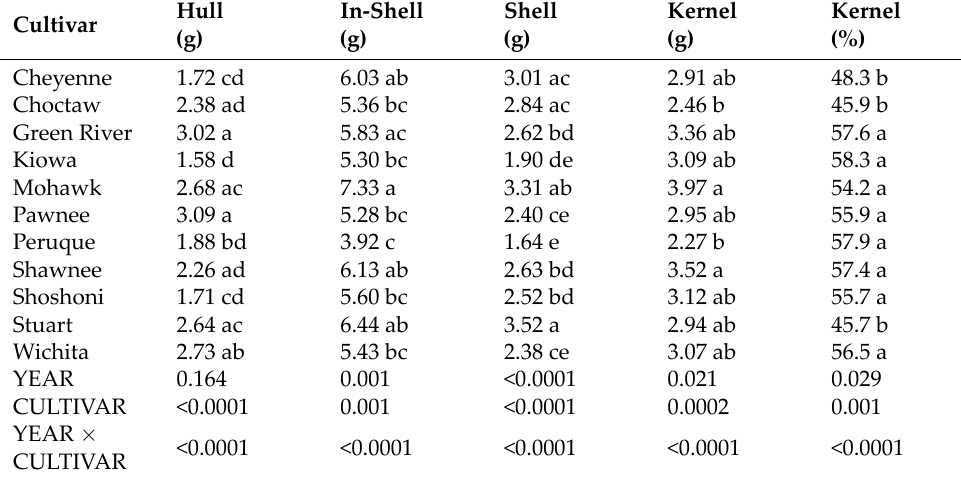
Table 2. Dry weight of fruit parameters as the average of 2018 and 2019 growing seasons a .